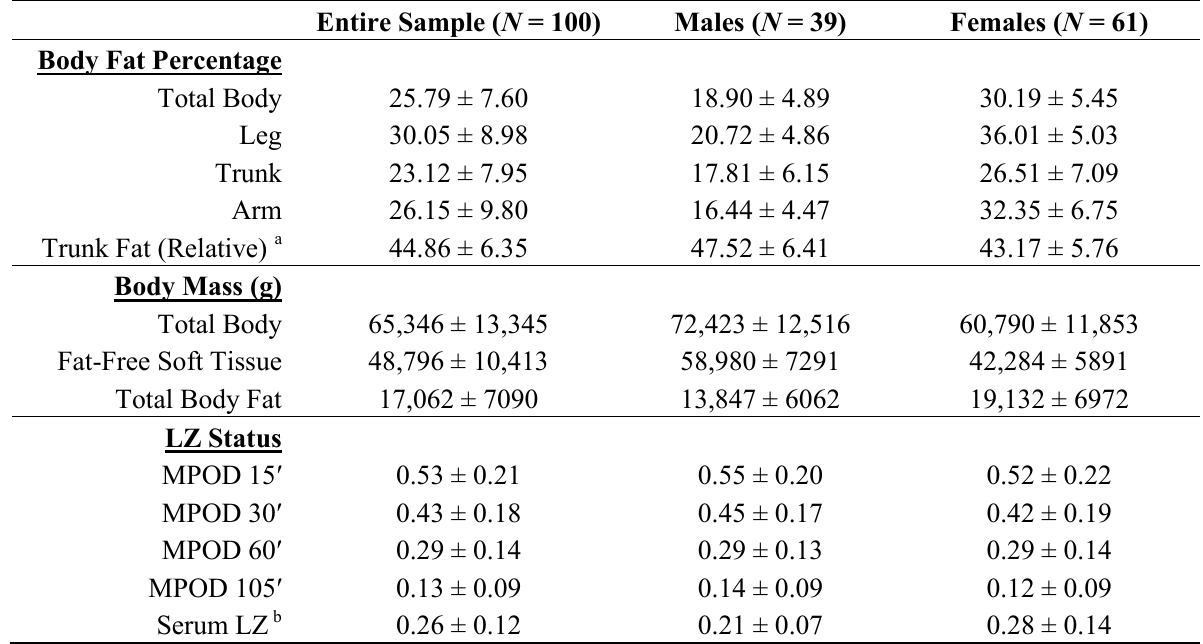
Table 1. Means and standard deviations for body composition variables and LZ